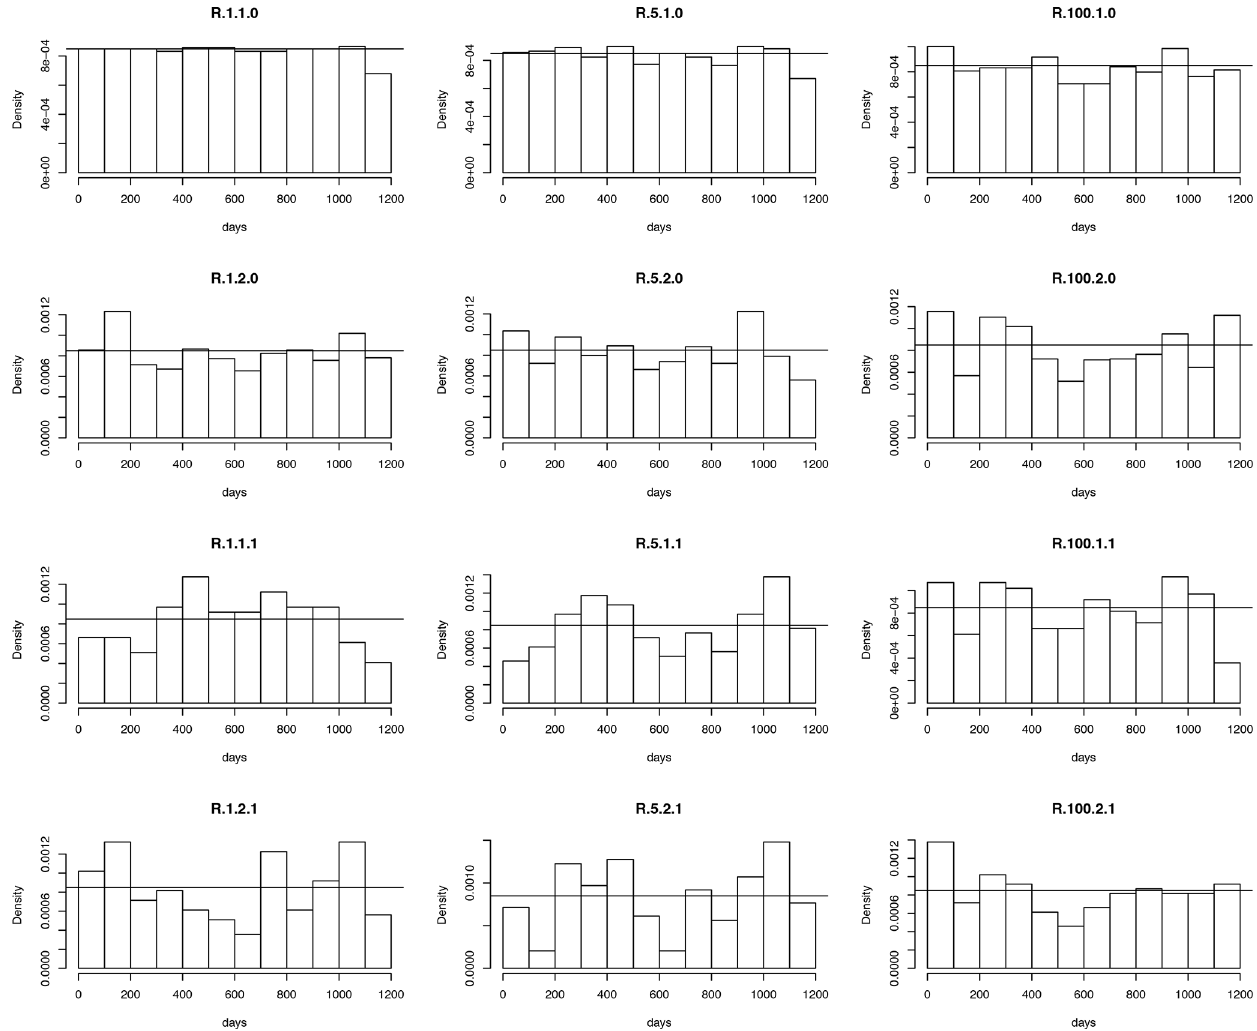
Figure 3. Distributions of time steps selected in the reference dataset in January by the different R 2 D 2 configurations. The equivalent histograms for April, July and October are provided in the Supplement in Figs.